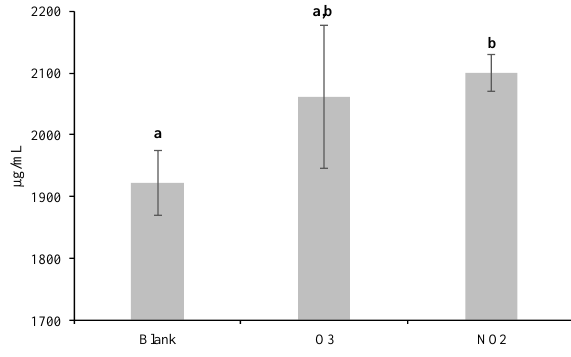
Figure 1. Average and standard deviation of the total soluble protein content of Dactylis glomerata pollen non-exposed to pollutants (Blank) and exposed to O 3 and NO 2 gaseous pollutants during 6 h at the limit value recommended for the protection of human health in Europe (O 3 : 0.061 ppm and NO 2 : 0.025 ppm; European Union Directive 2008/50/EC). Different letters indicate values statistically significantly different (ANOVA test followed by Tukey HSD post hoc, p < 0.05).